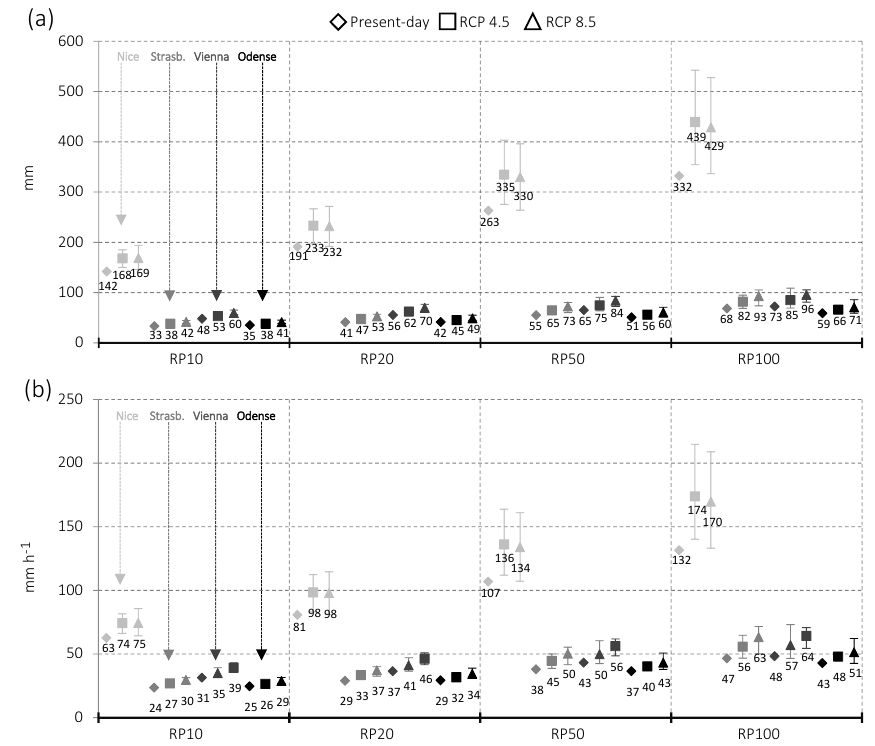
Figure 4. (a) Total precipitation and (b) maximum 1h precipitation intensities during the individual design events for Nice, Strasbourg, Vienna and Odense. Total precipitation duration is 4h. Error bars for the RCP 4.5 and RCP 8.5 represent low/high climate factors (CFs) respectively (low CF is in the 10th percentile and high CF is in the 90th percentile).